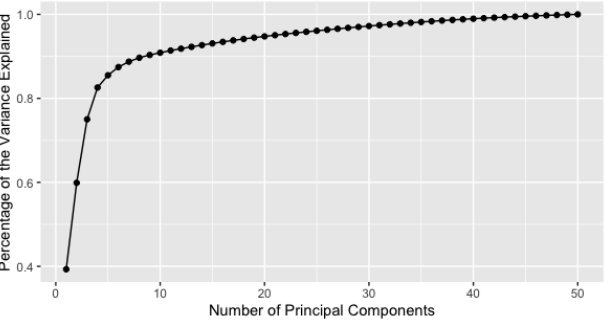
Figure 6. Cumulative proportions of variance explained by various numbers of principal components based on the 50 selected genes.